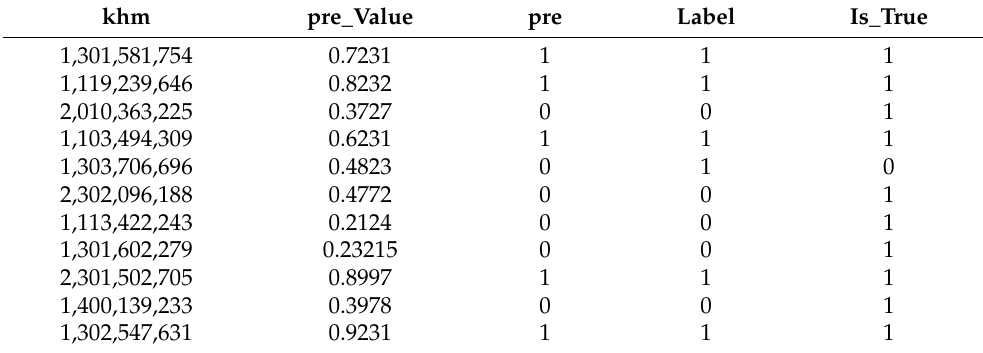
Table 3. Projected results for selected